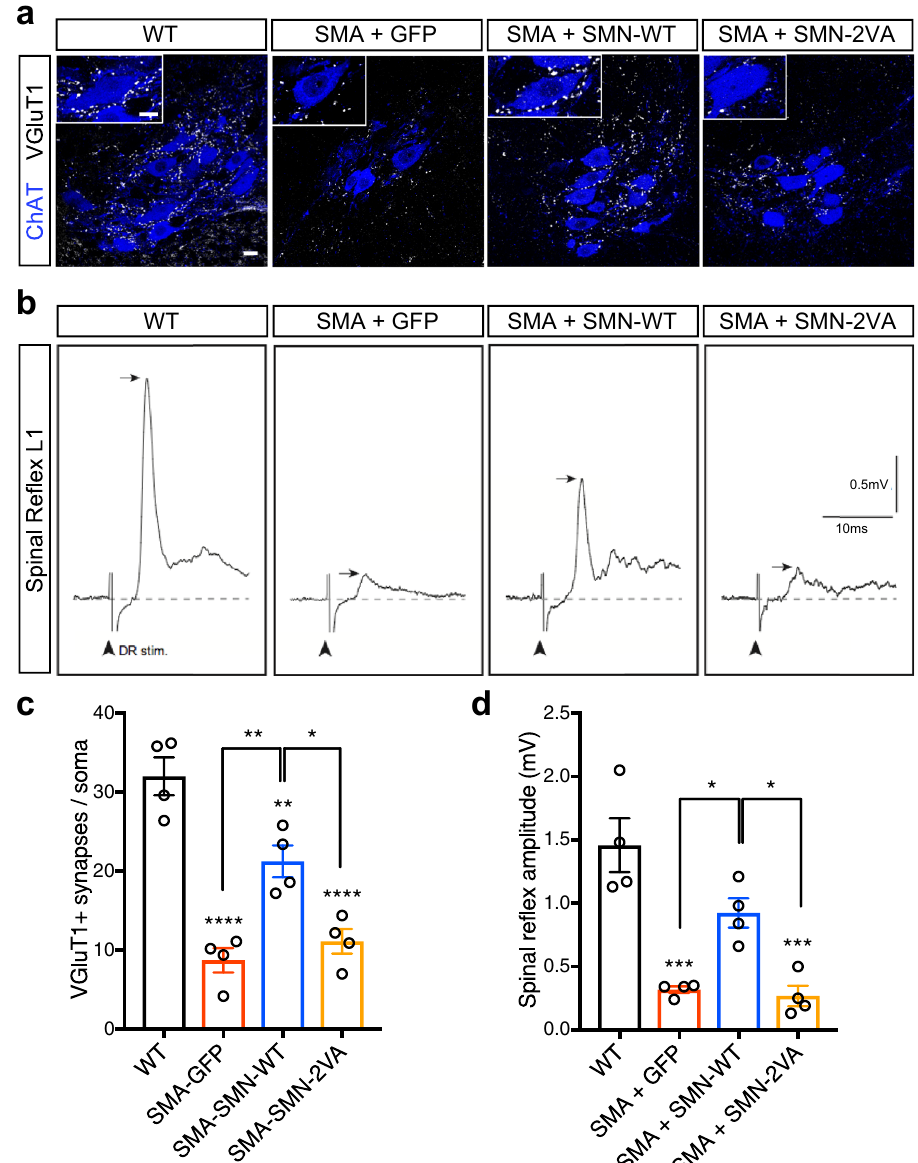
Fig. 8 SIM-less SMN fails to rescue sensory-motor circuit dysfunctions in SMA mice. a Immunostaining of VGluT1 + synapses (white dots) and ChAT + MNs (blue) in L1 spinal cord sections from WT mice or SMA mice injected with AAV9-GFP, AAV9-SMN-WT or AAV9-SMN-2VA at P9. Scale bar = 20 µ m; scale bar of the insert = 10 µ m. b Representative traces of extracellular recordings from L1 ventral root following L1 dorsal root stimulation from WT mice or SMA mice injected with AAV9-GFP, AAV9-SMN-WT or AAV9-SMN-2VA at P9. Arrows indicate the maximum amplitude of the monosynaptic re fl ex. Arrowheads indicate the stimulus artifact. Scale bars = 0.5 mV and 10 ms. c Number of VGluT1 + synaptic boutons (white dots) on the somata of L1 MNs (blue) from the same groups as in ( a ) at P9. Data represent mean and SEM from WT, SMA + AAV9-GFP, SMA + AAV9-SMN-WT, and SMA + AAV9-SMN-2VA (average of boutons counted for at least 15 cells from 4 animals for each group, n = 4 animals). Statistical signi fi cance was determined by one-way ANOVA with Tukey ’ s post hoc test (adjusted P values: WT vs. SMA + GFP p < 0.0001; WT vs. SMA + SMN-WT p = 0.0085;